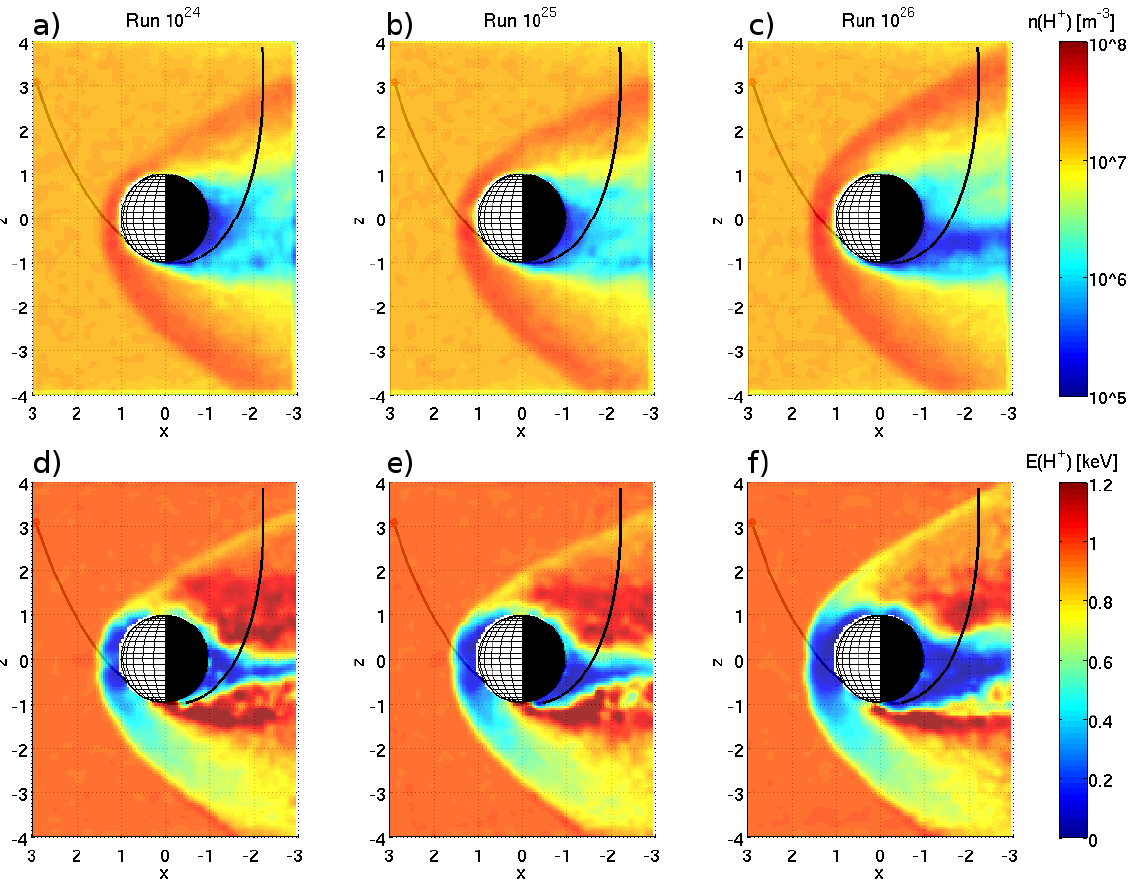
Fig. 7. Density (upper panels) and bulk flow energy (lower panels) of the solar wind H + at the y = 0 plane in three HYB-Venus simulation runs with different O + emission rates. The emission rates are (from the left): 10 24 , 10 25 (nominal) and 10 26 s − 1 th